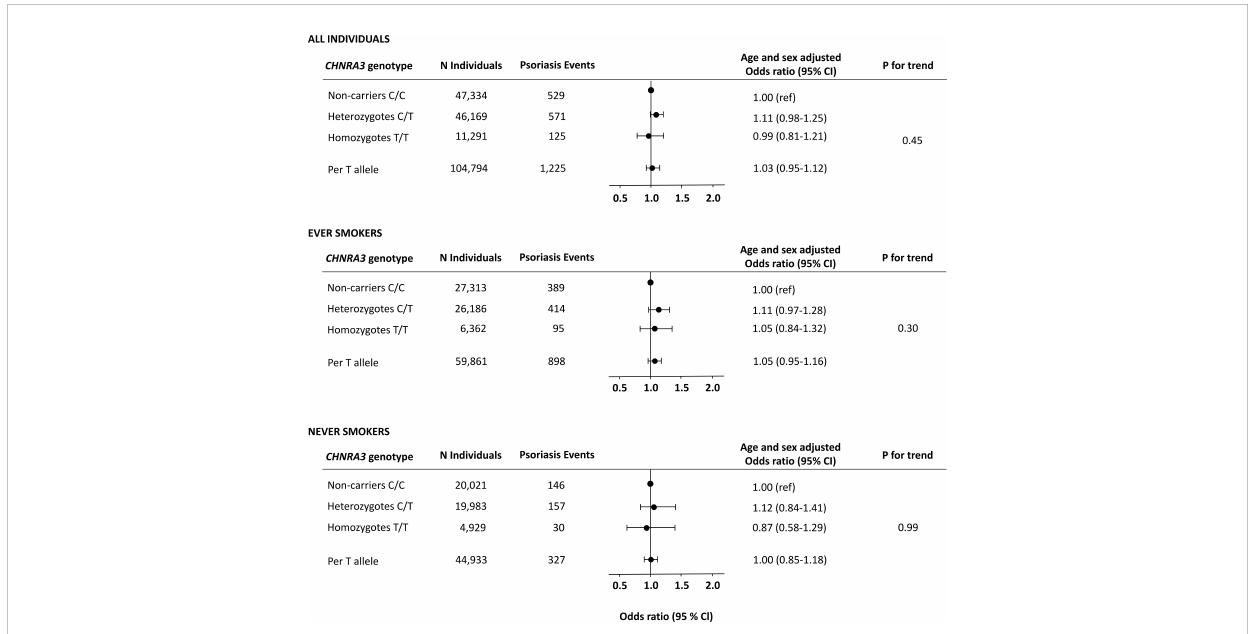
FIGURE 3 Risk of moderate to severe psoriasis as a function of the CHRNA3 rs1051730 genotype in individuals from the Copenhagen General Population Study. Analyses were adjusted for age and sex. Upper panel: All individuals. Middle panel: Never smokers. Lower panel: Ever